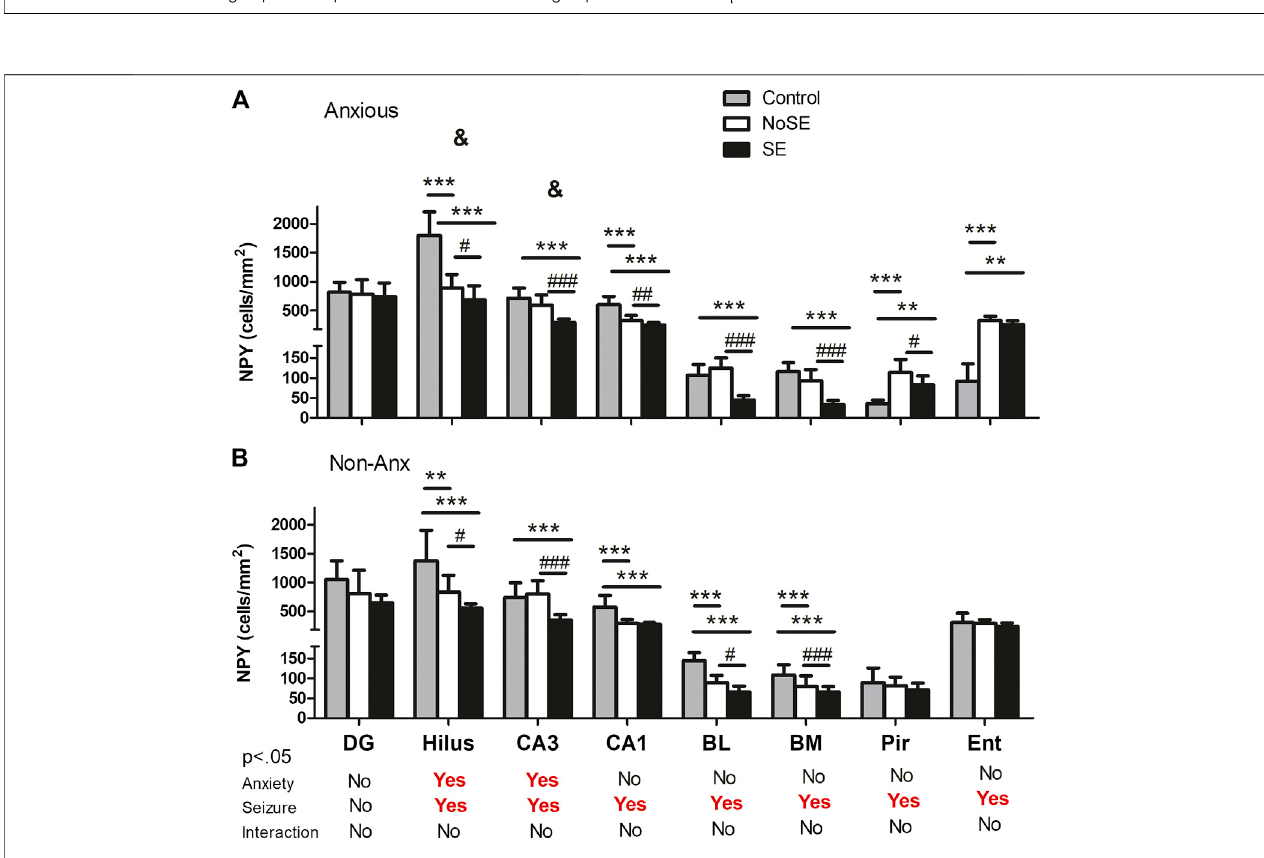
FIGURE 4 | Density of NPY + cells in several regions 90 days after pilocarpine injection. (A) Anxious group. (B) Non-Anxious group. The NPY + cell density in the hilus and CA3 hippocampal regions was in fl uenced by anxiety ( & A vs B). Most differences occurred within groups, where pilocarpine injection and SE development in fl uenced the NPY + cell density as compared to controls (except for the dentate gyrus, and the piriform and entorhinal cortices in Non-Anx animals, A and B). Values: mean ± SEM. Two-Way ANOVA, Bonferroni post hoc test, & p < 0.05 Anxious vs Non-Anxious; SE group vs Controls (** p < 0.01, *** p < 0.001) and SE group vs NoSE( # p < 0.05,## p < 0.01,### p < 0.001).NPY,neuropeptideY;DG,dentategyrus;BL,basolateralamygdala;BM,basomedialamygdala;Pir,piriform;Ent,entorhinal